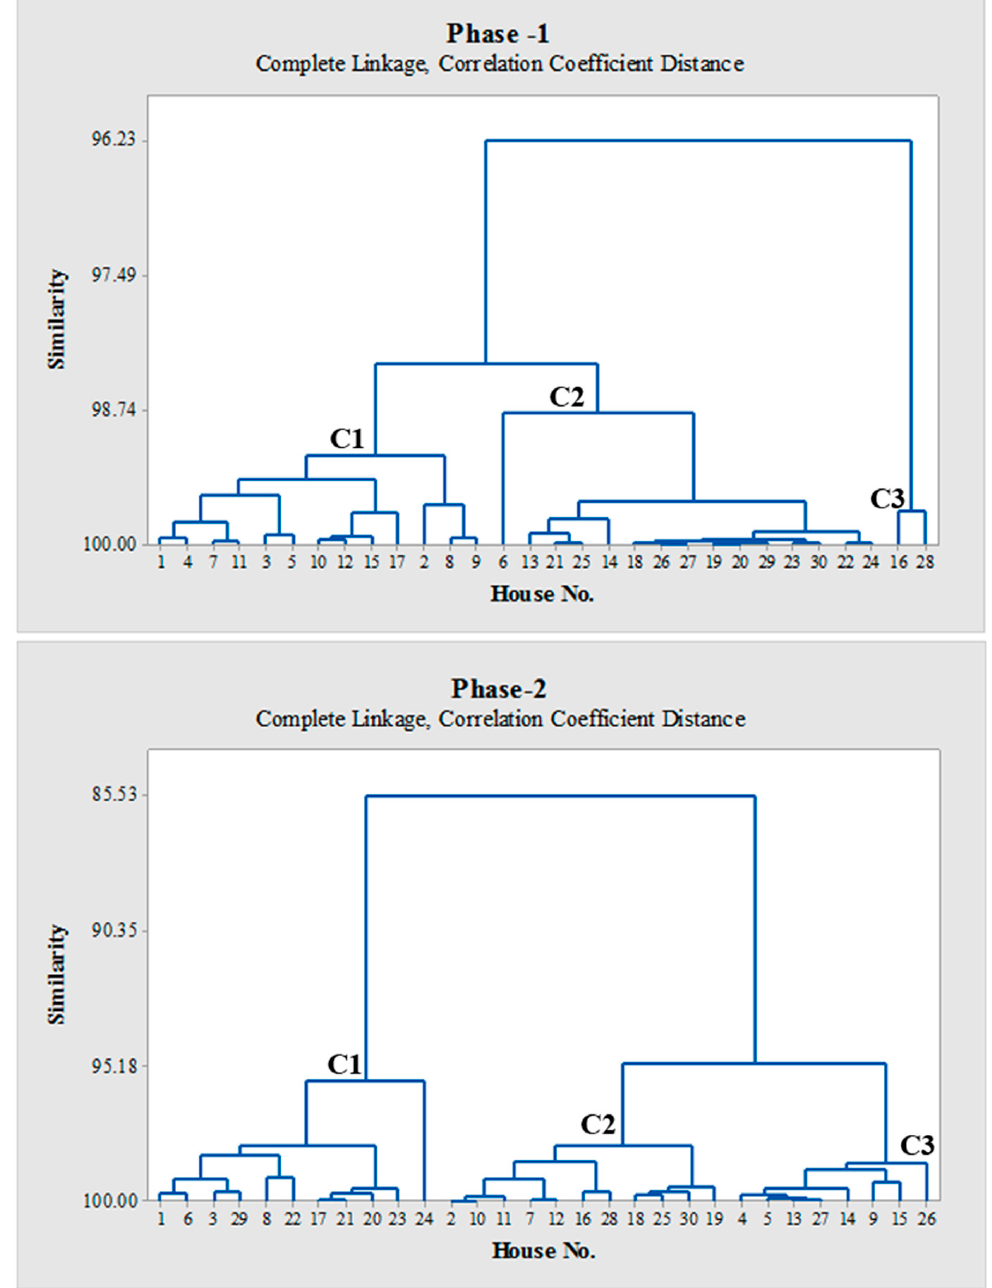
Figure 4. Dendrogram showing phase-1 and phase-2 clusters for 30 houses in the Baniyas region.